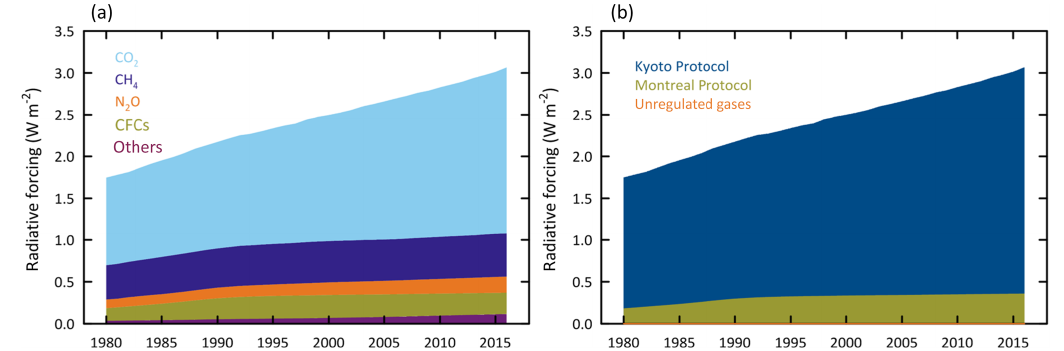
Figure 7. Global total radiative forcing due to long-lived greenhouse gases derived from NOAA-GMD measurements for CO 2 and AGAGE observations for all others (a) . Also shown are the contributions from the gases in the Kyoto and Montreal Protocol and those not regulated by either protocol (b)